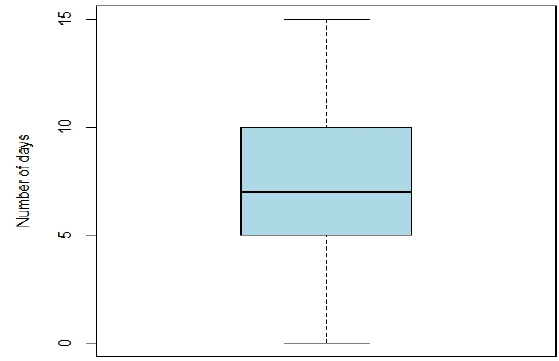
Figure 1. Duration of postoperative antibiotic therapy. Table 2. Details of Surgical Site Infection.